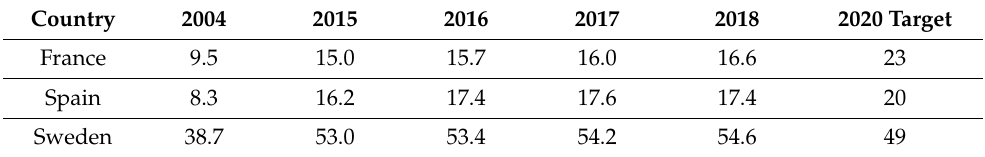
Table 1. Share of energy from renewable sources as a % of gross final energy consumption.